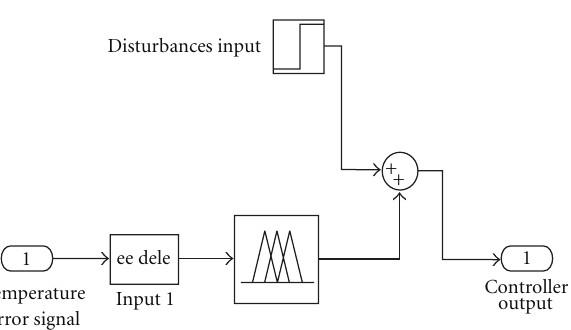
Figure 8: Simulink model of fuzzy